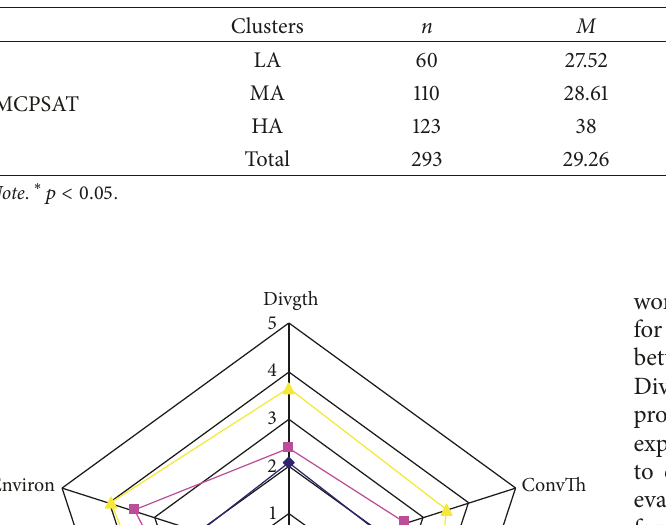
Table 5: Mean and SD of MCPSAT and group differences between three clusters.